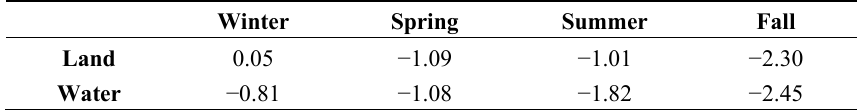
Table 1. Change in total cloudiness over land and water as measured from 1981 to 2012 using the PATMOS-x AVHRR record over the region show in Figure 3. The units are change in percent cloudiness per